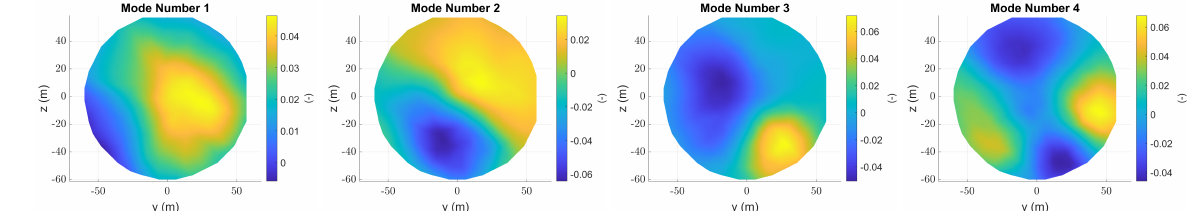
Figure 6. POD modes 1 to 4 of the line-of-sight ( v los ) measurements for the SBL case.